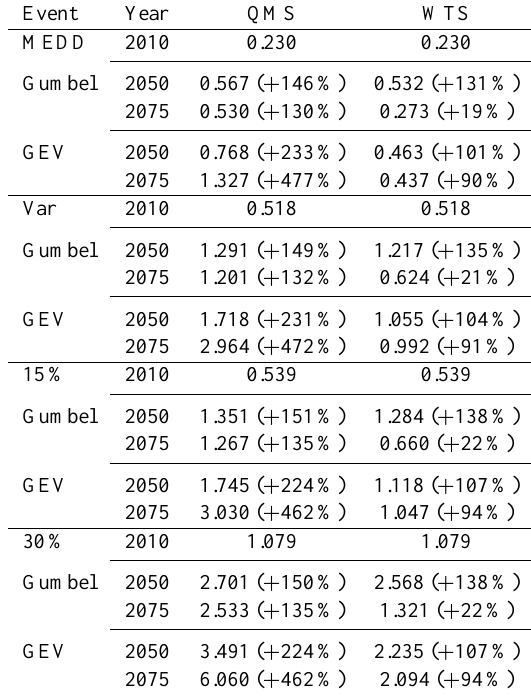
Table 4. Expected costs of floods on Mainland France and on the sub-catchments with stations, in billion Euro. The 100-yr return pe- riod event is taken as a reference event.